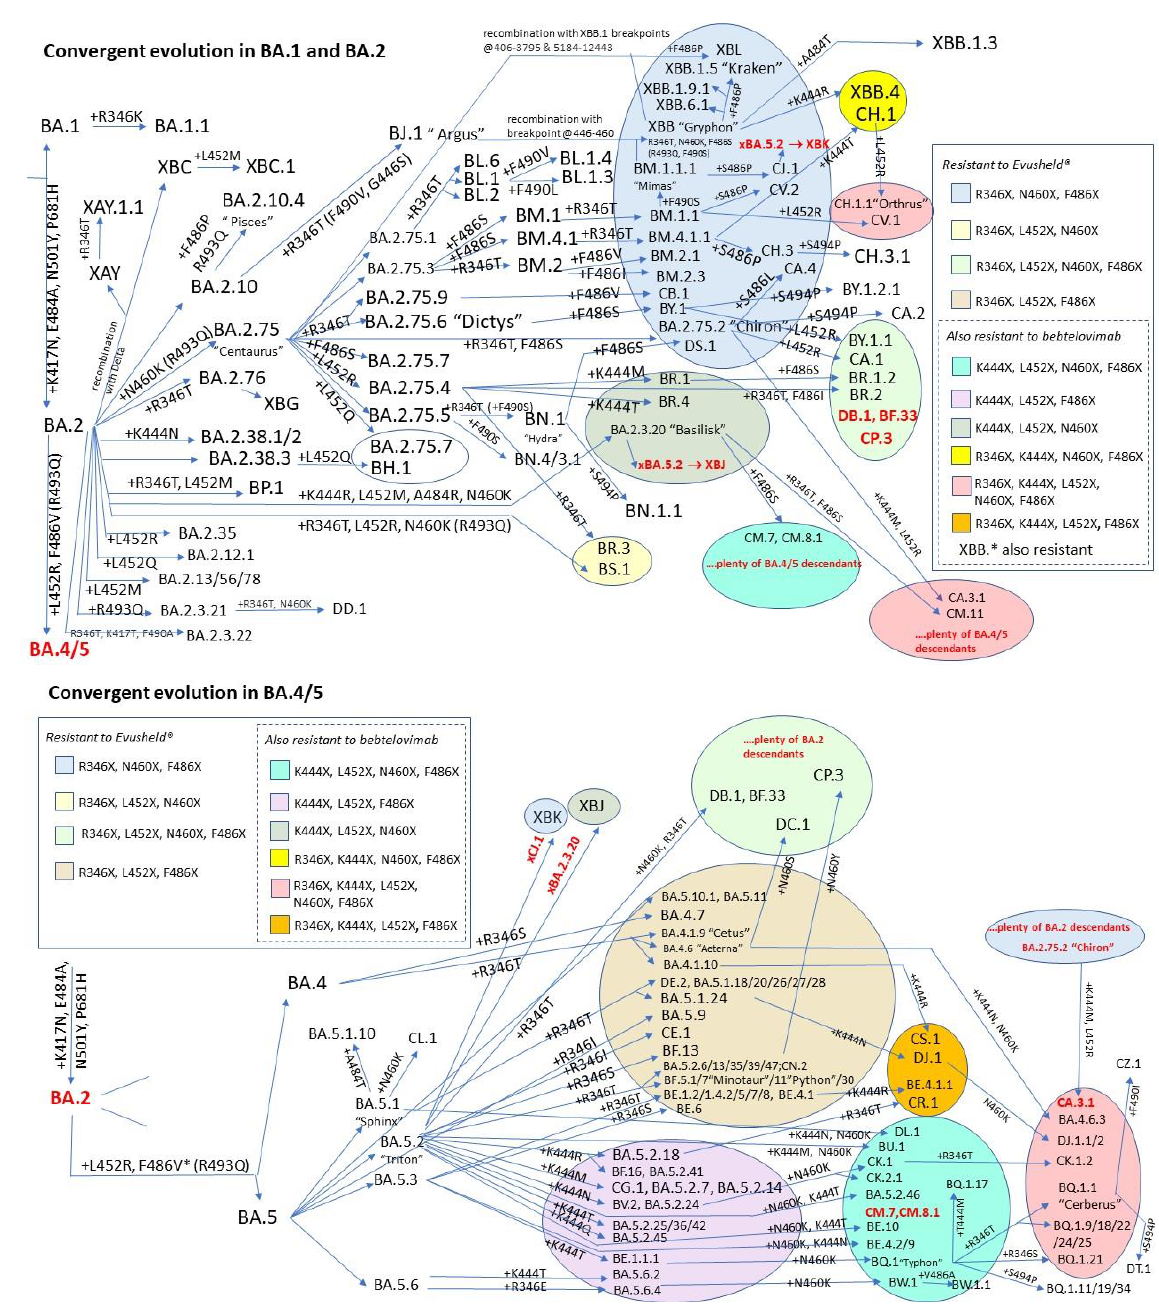
Figure 3. Diagram representing all SARS-CoV-2 Omicron sublineages designated by PANGOLIN as of 26 December 2022 for which at least one of the Spike RBD immune escaping mutations (R346X, K444X, L452X, N460X, F486X, or R493Q) represents a branching event. Mythological names introduced by T Ryan Gregory and used colloquially are also reported. Convergence towards combos of this mutations is noted, with different background colors representing different combinations. Resistance of each combination to clinically authorized anti-Spike mAbs is reported in the squared box. For visualization purposes, the upper panel shows BA.1 and BA.2 evolution, while the lower panel shows BA.4/5 evolution.